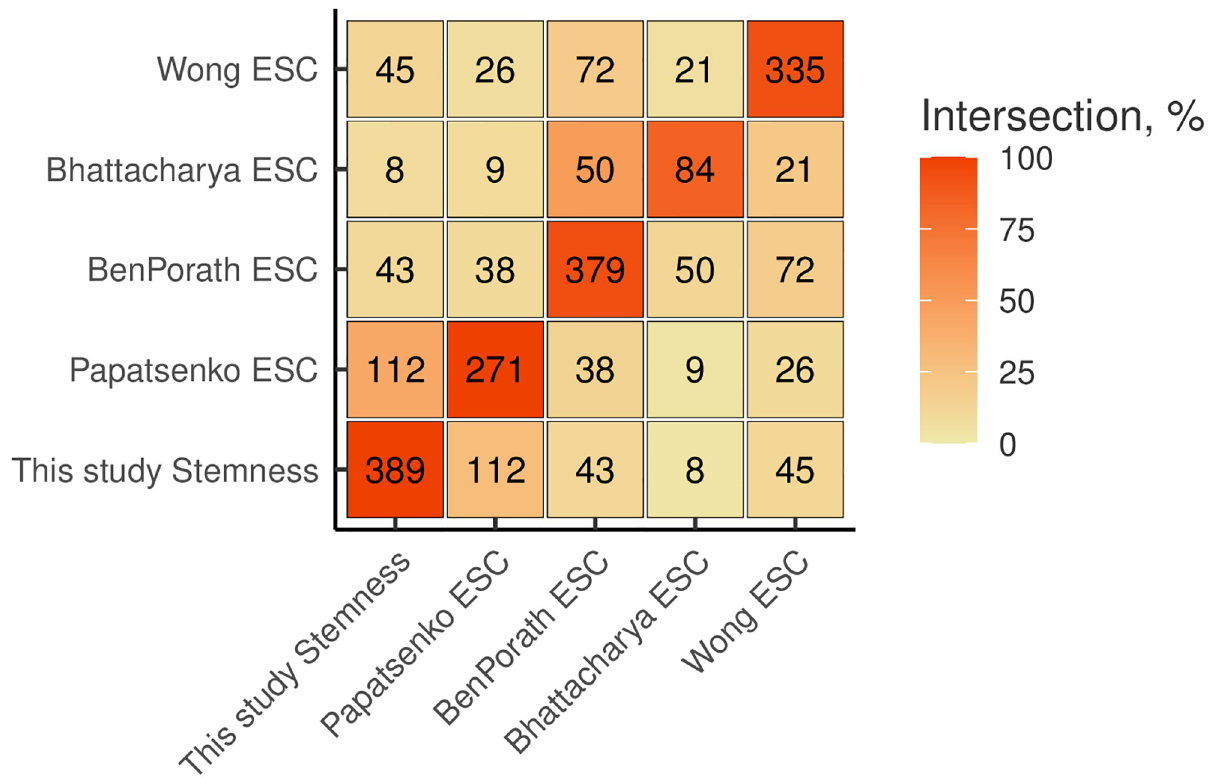
Fig 1. The stemness signature gene set intersects with previously published ESC signature gene sets. The number of genes in the intersection between sets on the X and Y axes is shown in the cells of the matrix. The color scale encodes the size of the intersection relative to the size of the dataset on the Y axis (above the diagonal) and relative to the size of the dataset on the X axis (below the diagonal).